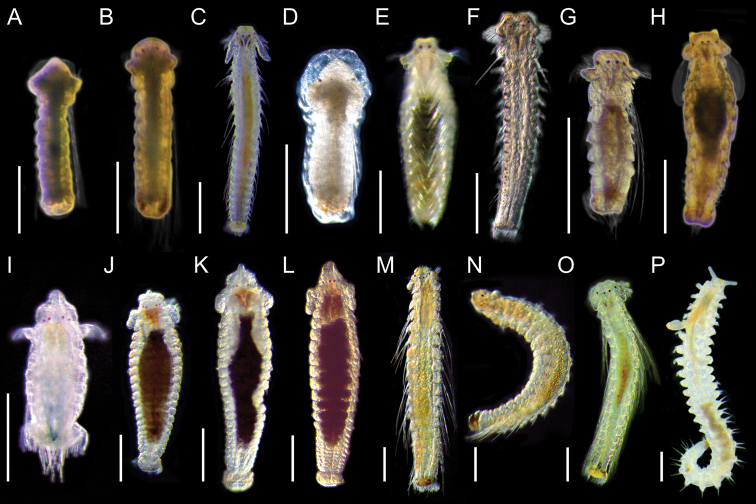
Light micrographs showing morphologies of living spionid larvae of Aonides, Laonice, Rhynchospio, Scolelepis, and SpiophanesA–CAonides
cf.
oxycephala, dorsal view of early planktonic (A), 8‐chaetiger (B), and 18‐chaetiger larvae (C) DLaonice sp. 1, dorsal view of early planktonic larva ELaonice sp. 2, dorsal view of 12‐chaetiger larva FPoecilochaetus sp., dorsal view of 17‐chaetiger larva G, HRhynchospio
aff.
asiatica, dorsal view of 6‐chaetiger (G) and 12‐chaetiger larvae (H) IScolelepis
cf.
kudenovi, dorsal view of 7‐chaetiger larva J, KScolelepis sp. 1, dorsal view of 17‐chaetiger (J) and 19‐chaetiger larvae (K) LScolelepis sp. 2, dorsal view of 20‐chaetiger larva M, NSpiophanes
uschakowi, dorsal (M) and lateral view (N) of 18‐chaetiger larvae O, PSpiophanes
aff.
uschakowi, dorsal view of 16‐chaetiger larva (O) and 27‐chaetiger juvenile (P). Scale bars: 300 μm.